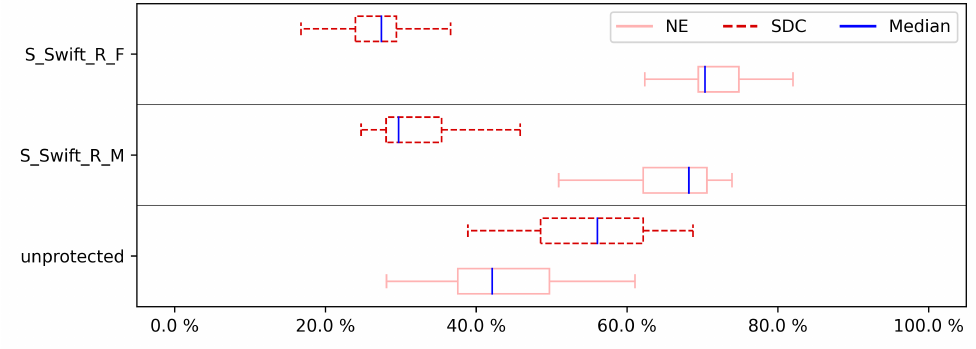
Figure 3. CFE fault injection results for 1 register.